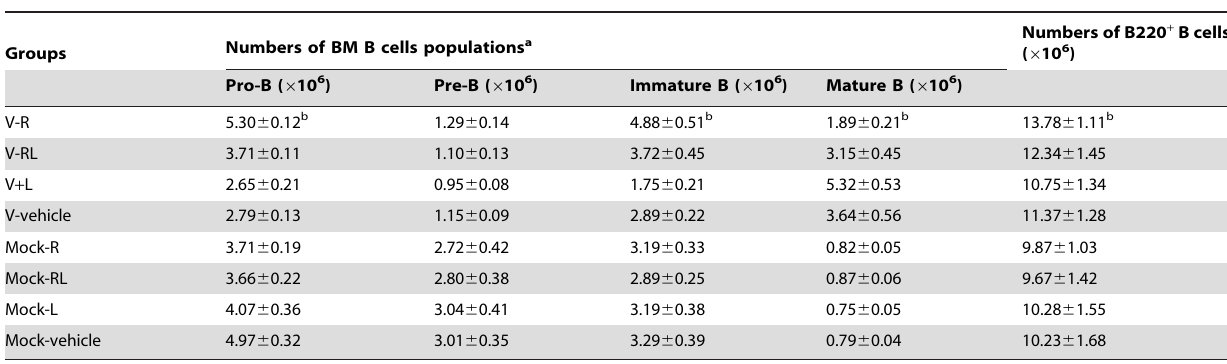
Table 1. Numbers of B lineage cells in BM following treatment with RU486 and/or Leptin.